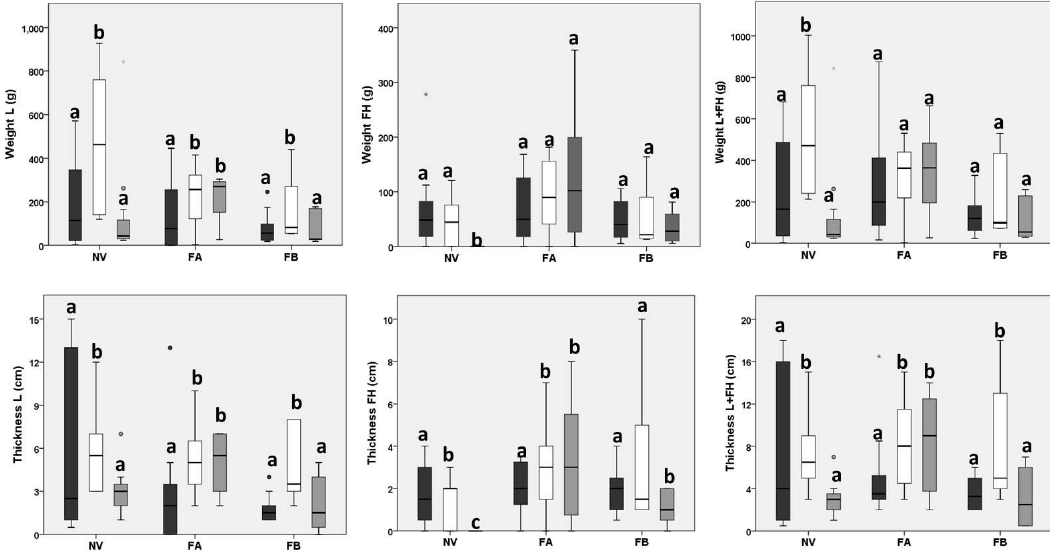
Figure 3. Weight (g) and thickness (cm) of litter before harvesting (2015, in black), as well as one year (2016, in white) and two years (2017, in grey) after harvesting for each locality (NV, FA, FB). L: litter layer and recognizable remains; FH: fragmented and humified remains. Values followed by the same letter do not differ significantly according to Newman-Keuls test ( p < 0.05).